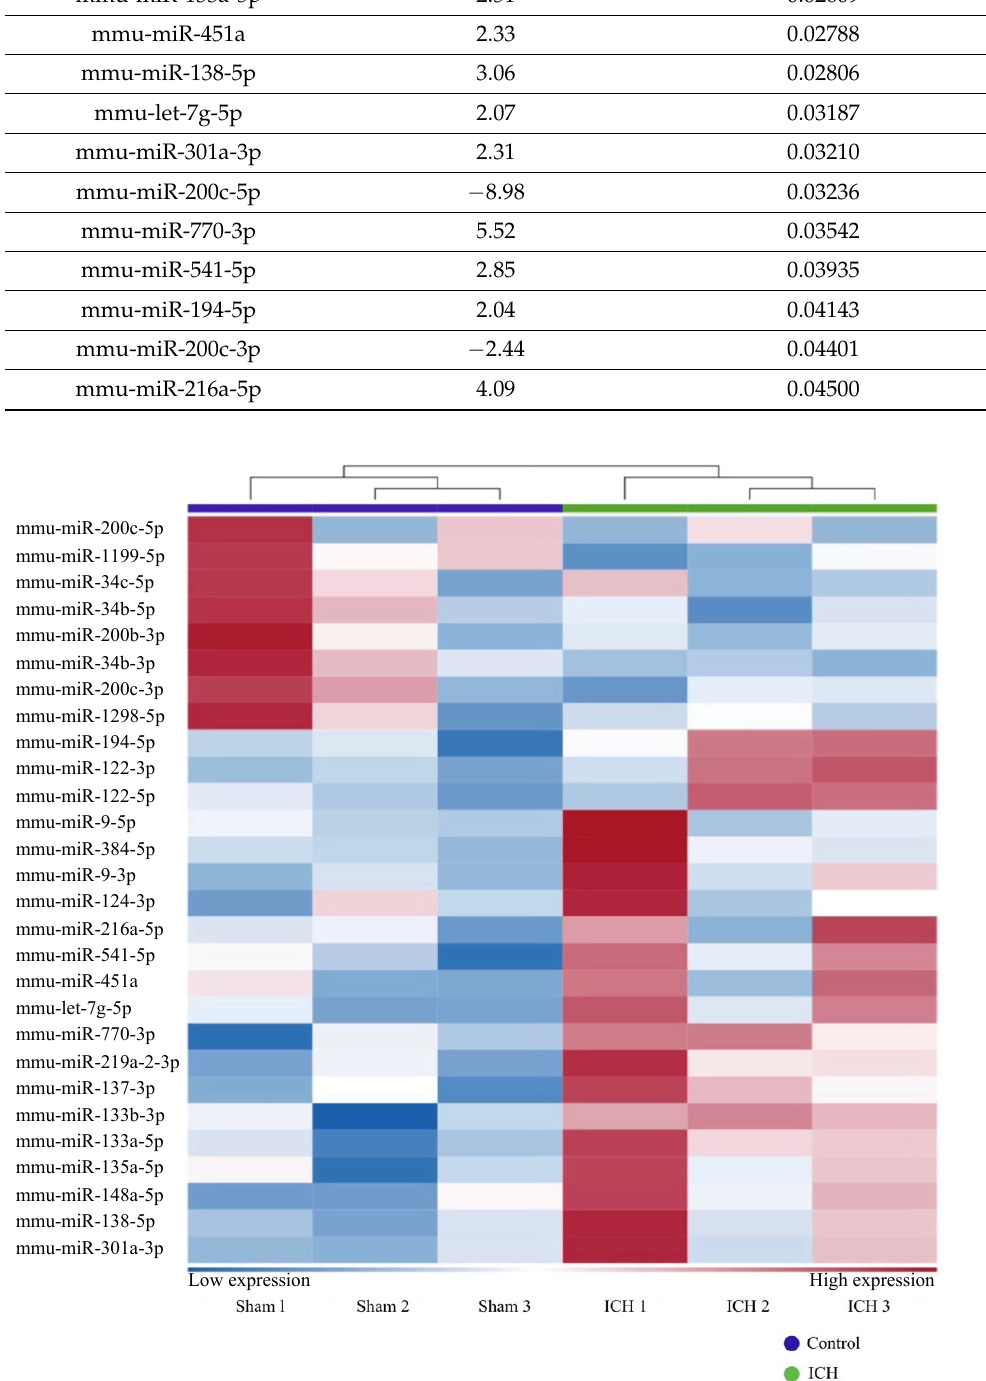
Figure 2. Heatmap representation of the differentially expressed serum miRNAs between sham and ICH. A total of 28 miRNAs exhibited a difference ( p < 0.05) in their expression between ICH and sham. The serum levels of 20 miRNAs were found to be significantly increased and serum levels of 8 miRNAs were significantly decreased after ICH in comparison to sham (n = 3 mice per group; p <